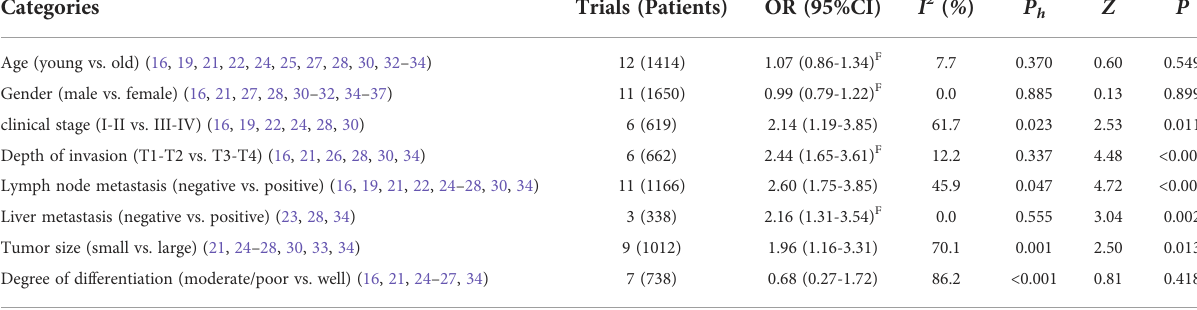
TABLE 3 Meta-analysis of MSI2 and clinicopathological features in cancer patients.